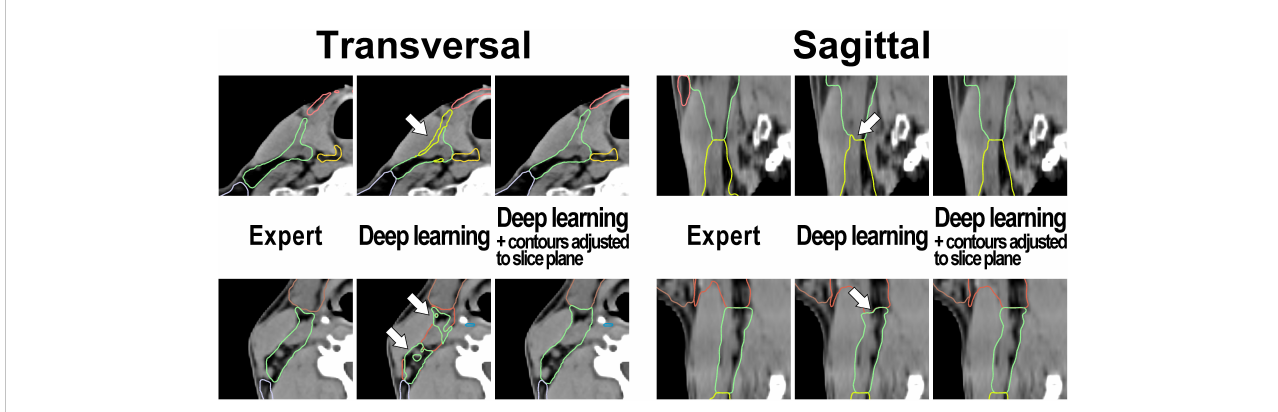
FIGURE 3 Examples illustrating the applied contour postprocessing step that aligns cranial and caudal level boundaries with the planning CT slice plane in test set patient cases. Left: transversal view and Right: sagittal view. Note (arrows): Inconsistencies of level boundaries with the CT slice plane in the output of the deep learning model (center image) that are absent in the expert-generated contour set (left image) and that are removed by the postprocessing step (right image).